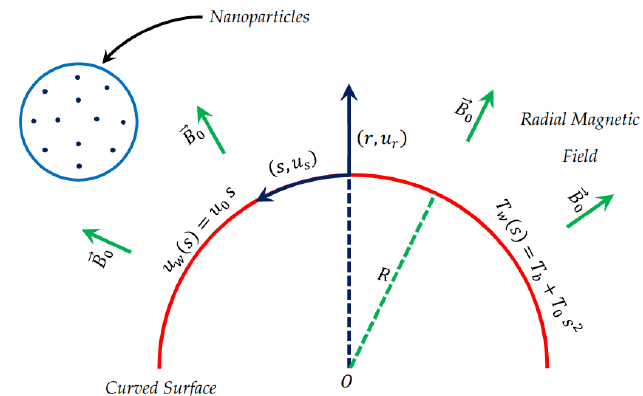
Figure 1. Description of the physical flow model in the curvilinear coordinate system. Table 1. Thermophysical properties of some nanoparticles and water [21,49,50]. abovementioned assumptions along with the Prandtl boundary layer Properties Base Fluid (Water) Ag (Silver) Cu (Copper) c p ( J / kgK ) 4179 235